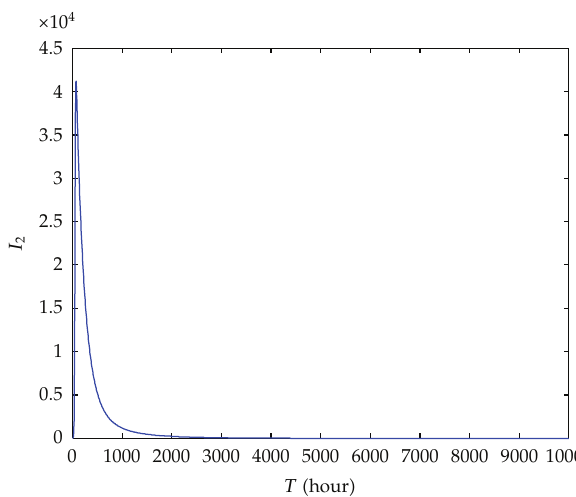
Figure 7: The result of virus propagation when g > g e